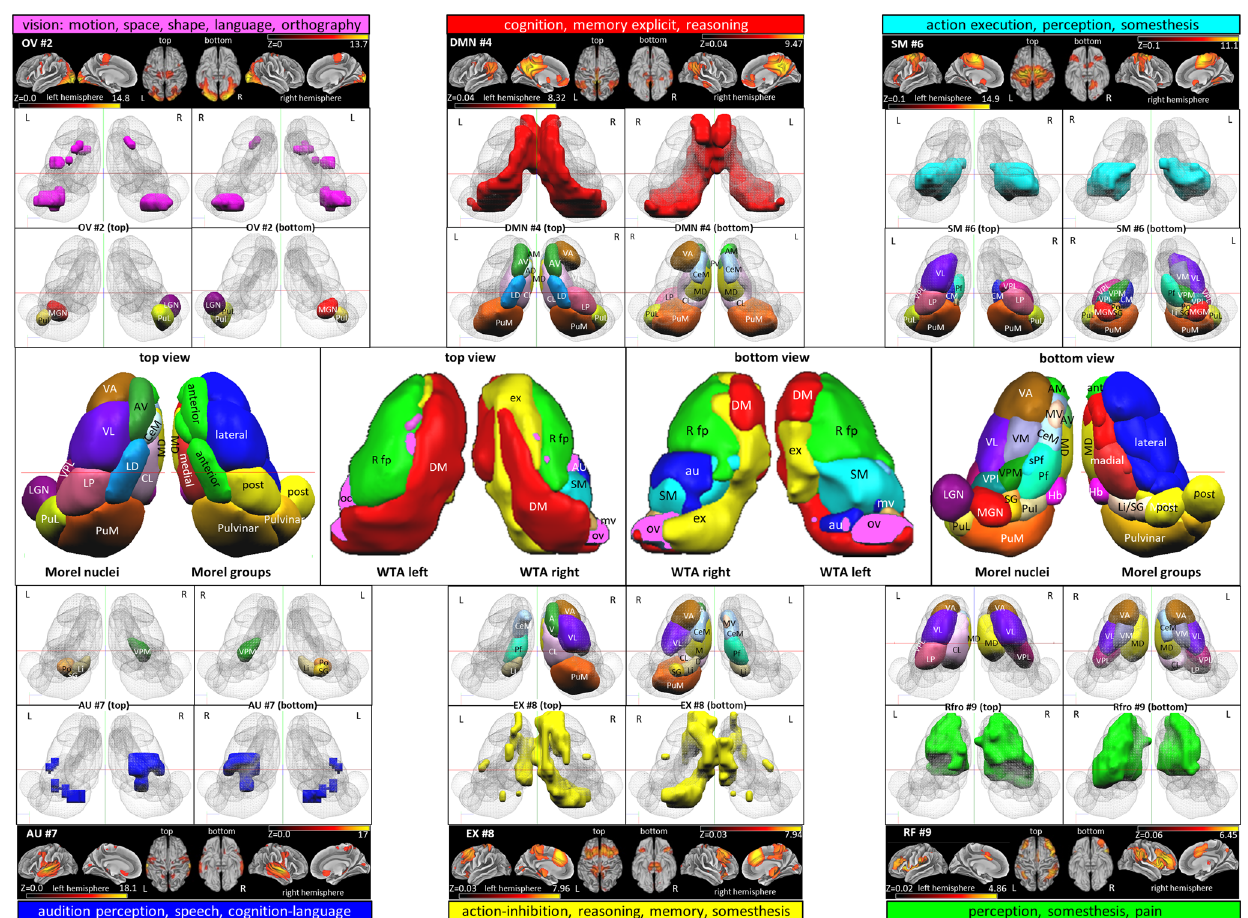
Fig. 6 Comparison of 6 WTA maps with histologically de fi ned thalamus nuclei. Top and bottom: the most apparent involvement of thalamic nuclei for six dominant RSN is depicted according to the Jülich Histology atlas. Surface views of cortical areas and their major functional assignments and corresponding thalamic nuclei exceeding ≥ 0. Two dice overlap (except for AU > 0.1) are shown. Middle: display of anatomy of thalamic nuclei according to Morel and WTA maps of the left and right hemispheres. The cortical maps ’ color bar scales are also given in Fig.